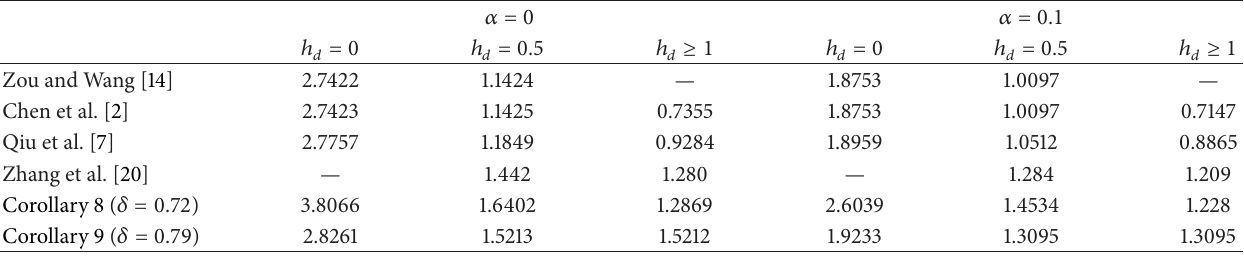
Table 3: Maximum upper bound of ℎ with 𝛽 = 0.1